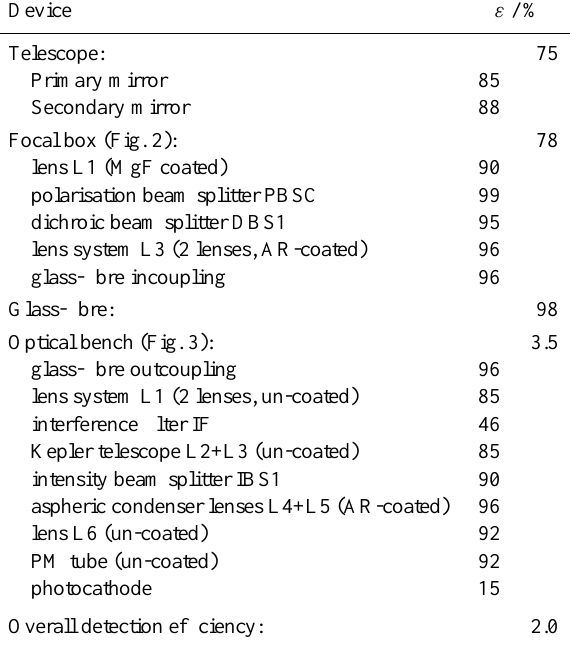
Table 6. Transmission and efficiency ε of the receiving system at 532-nm wavelength in parallel polarisation. Abbreviations are ac- cording to Figs. 2 and